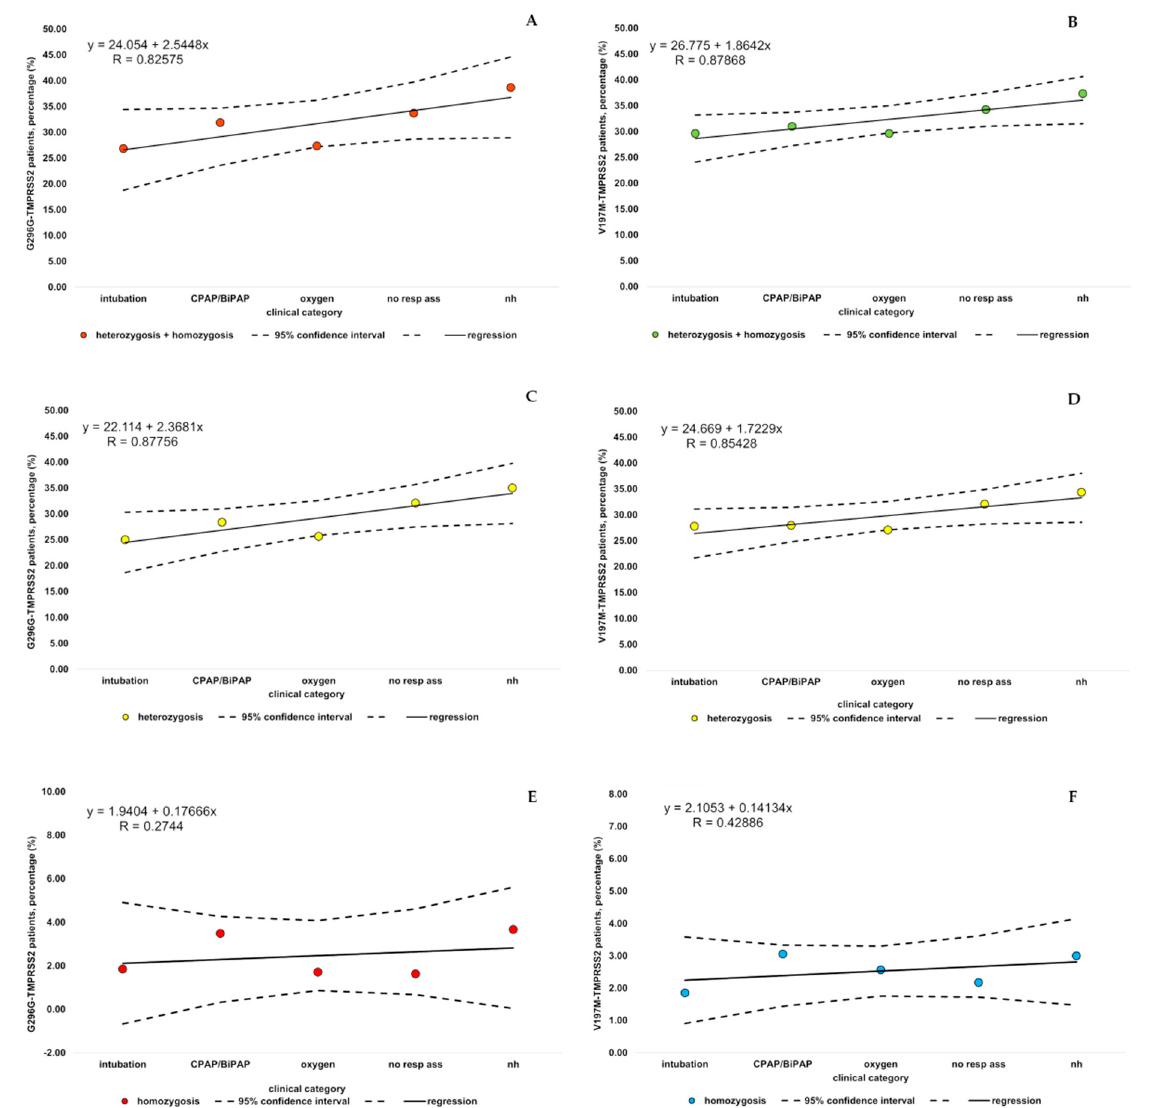
Figure 1. Prevalence of p.G296G or p.V197M in COVID-19 patients subdivided by different clinical outcomes. The percentages of carriers ( A , B ), heterozygous ( C , D ) and homozygous ( E , F ) individuals for p.G296G ( A , C , E ) or p.V197M ( B , D , F ) in each clinical category, i.e., patients who needed intubation, ventilation (CPAP/BiPAP), or oxygen therapy, patients who did not need oxygen therapy (no resp support) or were not hospitalized (nh), are reported. The 95% confidence interval around the regression line is calculated as the product of the regression standard error and the value of the 0.975-th quantile of a t distribution with 3 degrees of freedom.